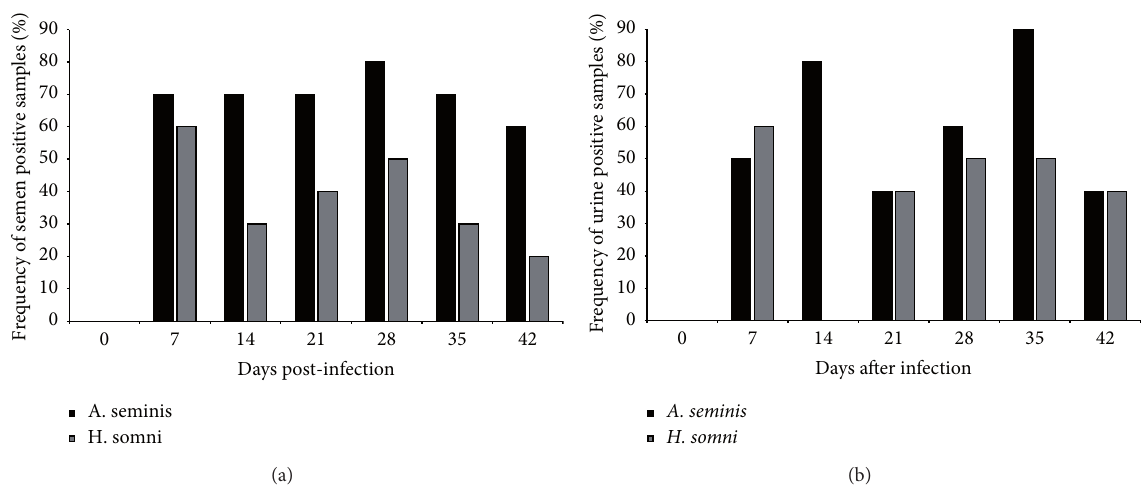
Figure 3: Frequency (%) of positive rams for bacterial isolation of Actinobacillus seminis ( 𝑛 = 10 ) or Histophilus somni ( 𝑛 = 10 ) over 42 days of experimental infection. (a) Semen and (b) urine.